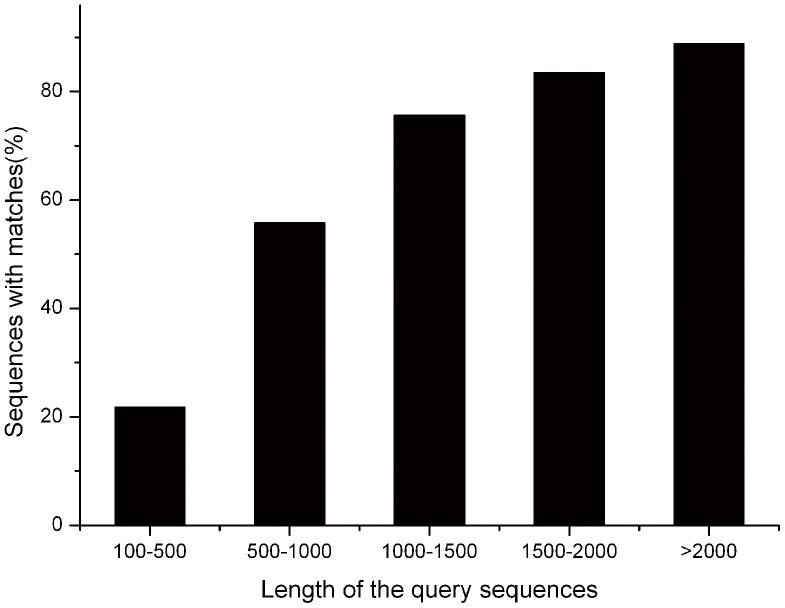
Effect of query sequence length on the percentage of sequences for which significant matches are found.The proportion of sequences with matches in NCBI nr databases is greater among the longer assembled sequences (with a cut-off E-value of 10−5).